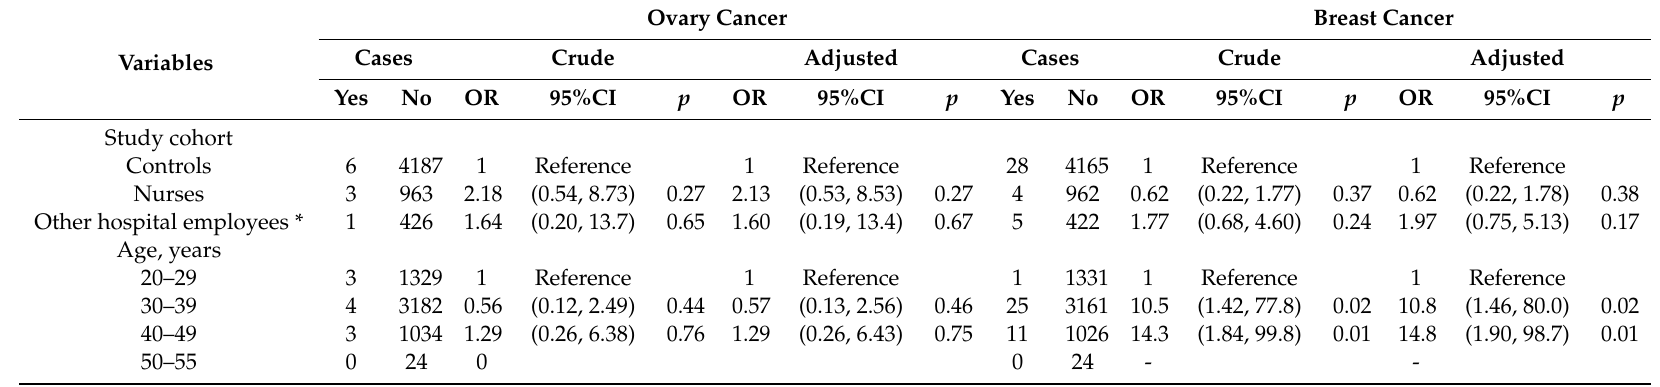
Table 3. Cases of ovary cancer and breast cancer developed among women with endometriosis and odds ratio of developing cancer by study cohort and age. Ovary Cancer Breast Cancer Cases Crude Adjusted Variables